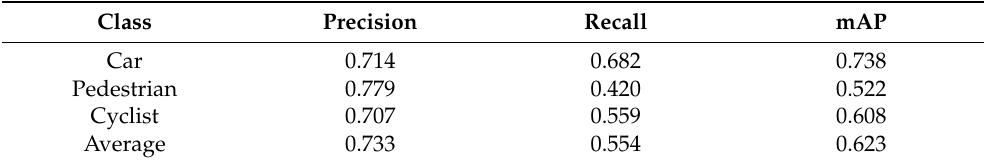
Table 7. Evaluation metrics for Medium (G2) compression KITTI point clouds converted with the Delaunay triangulation method and evaluated using the best YOLOv5m model obtained with Bilateral Filter-generated